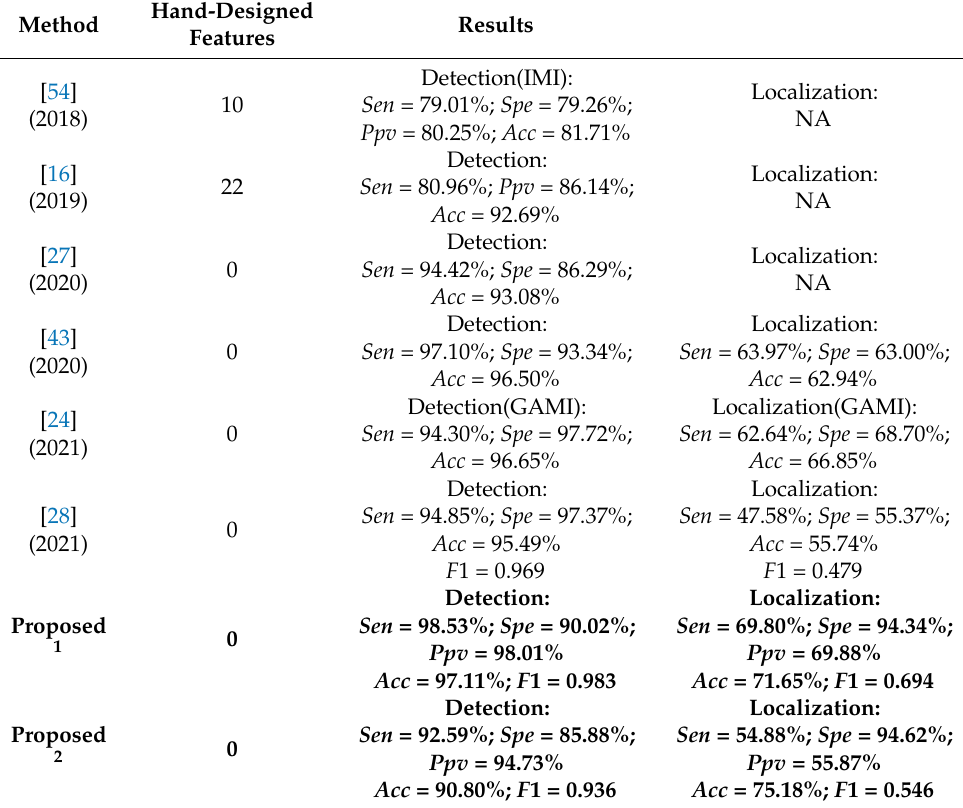
Table 7. Comparison between existing methods and ours on MI Diagnosis using ECGs.